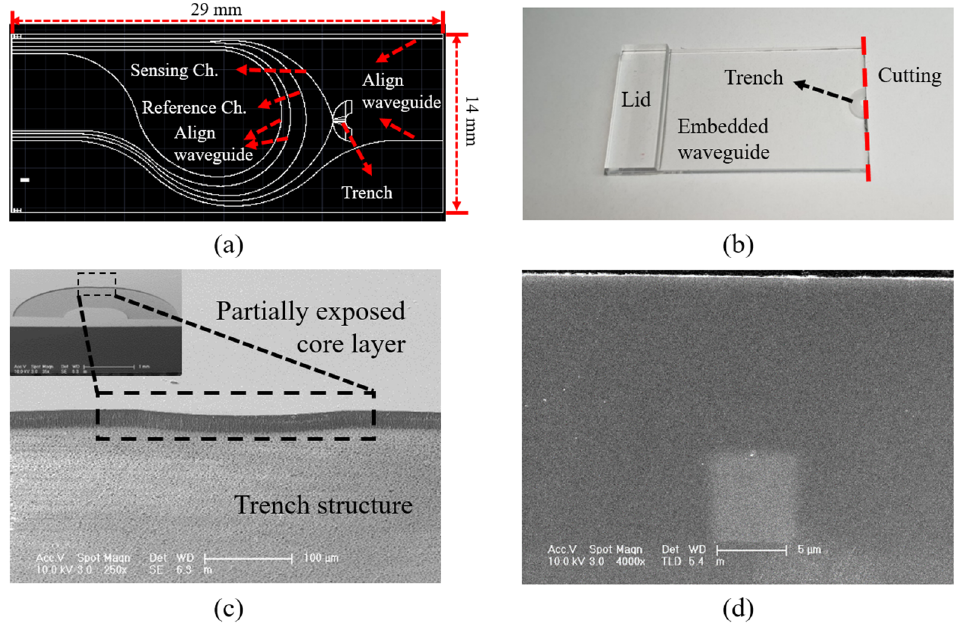
Figure 5. Integrated PLC sensor probe device with the partially exposed core layer: ( a ) PLC device design; ( b ) fabricated PLC device; ( c ) scanning electron microscope (SEM) image of the etched trench structure; ( d ) cross-sectional SEM image of the fabricated PLC device.